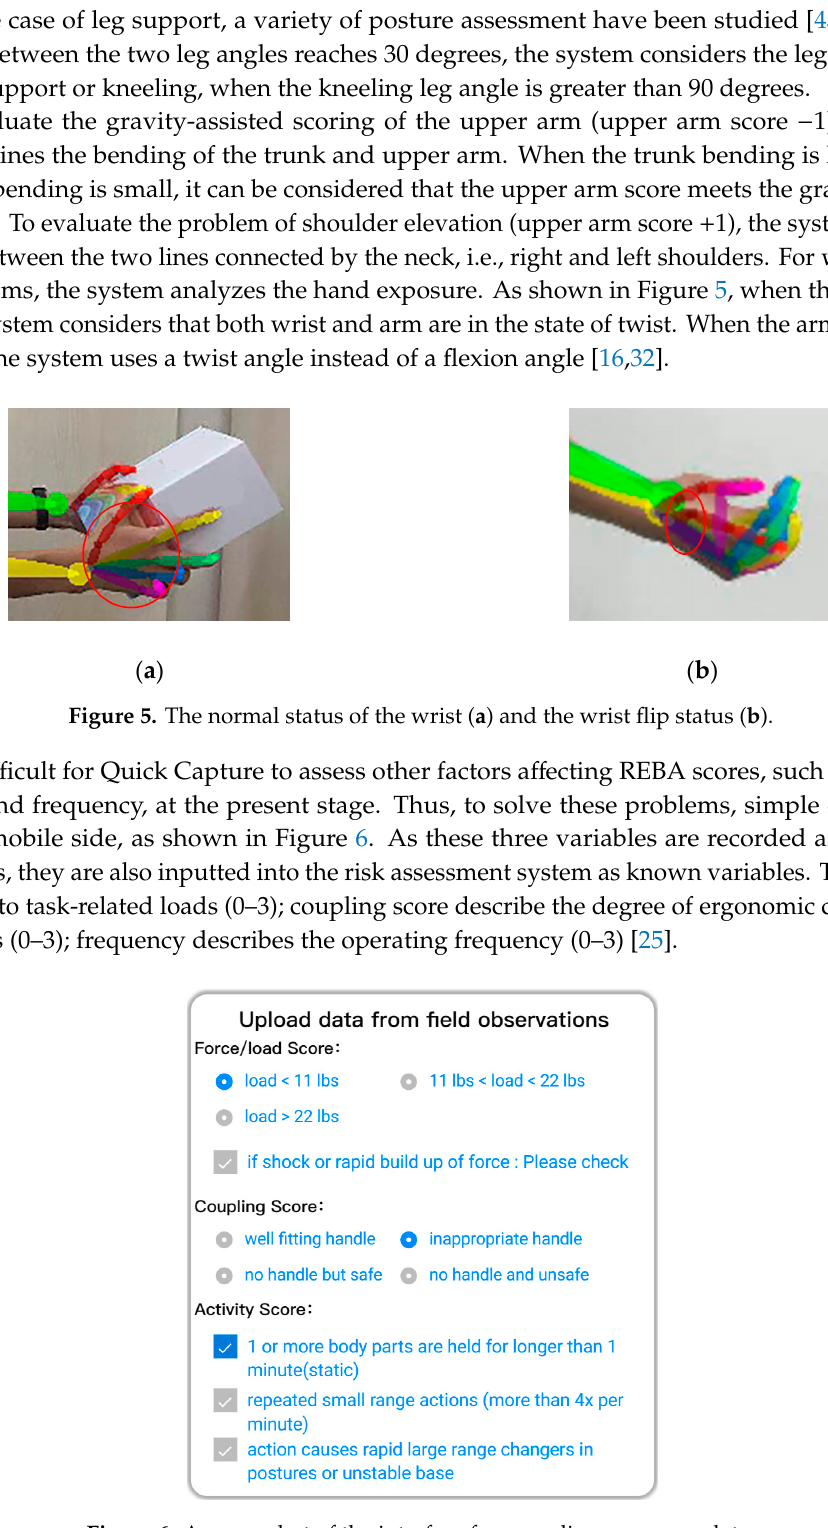
Figure 6. A screenshot of the interface for recording necessary data.